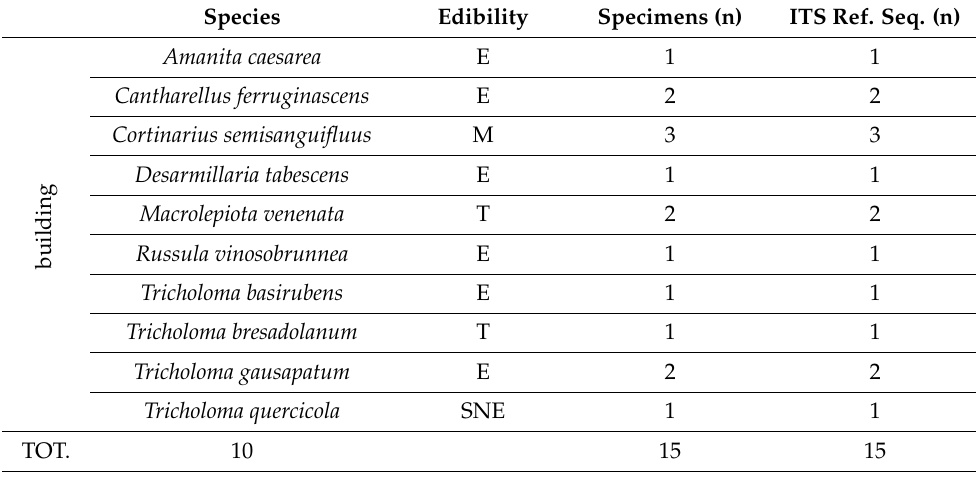
Table 2. Samples collected in this study (species and specimens number) and obtained ITS reference sequences used to set up and validate the ITS gene dataset. * sequences matching uniquely with the corresponding species but with identity values < 97%; ** sequences simultaneously matching with the corresponding species and one other of the same edibility, with identity values ≥ 98%. Species Edibility Specimens (n) ITS Ref. Seq.